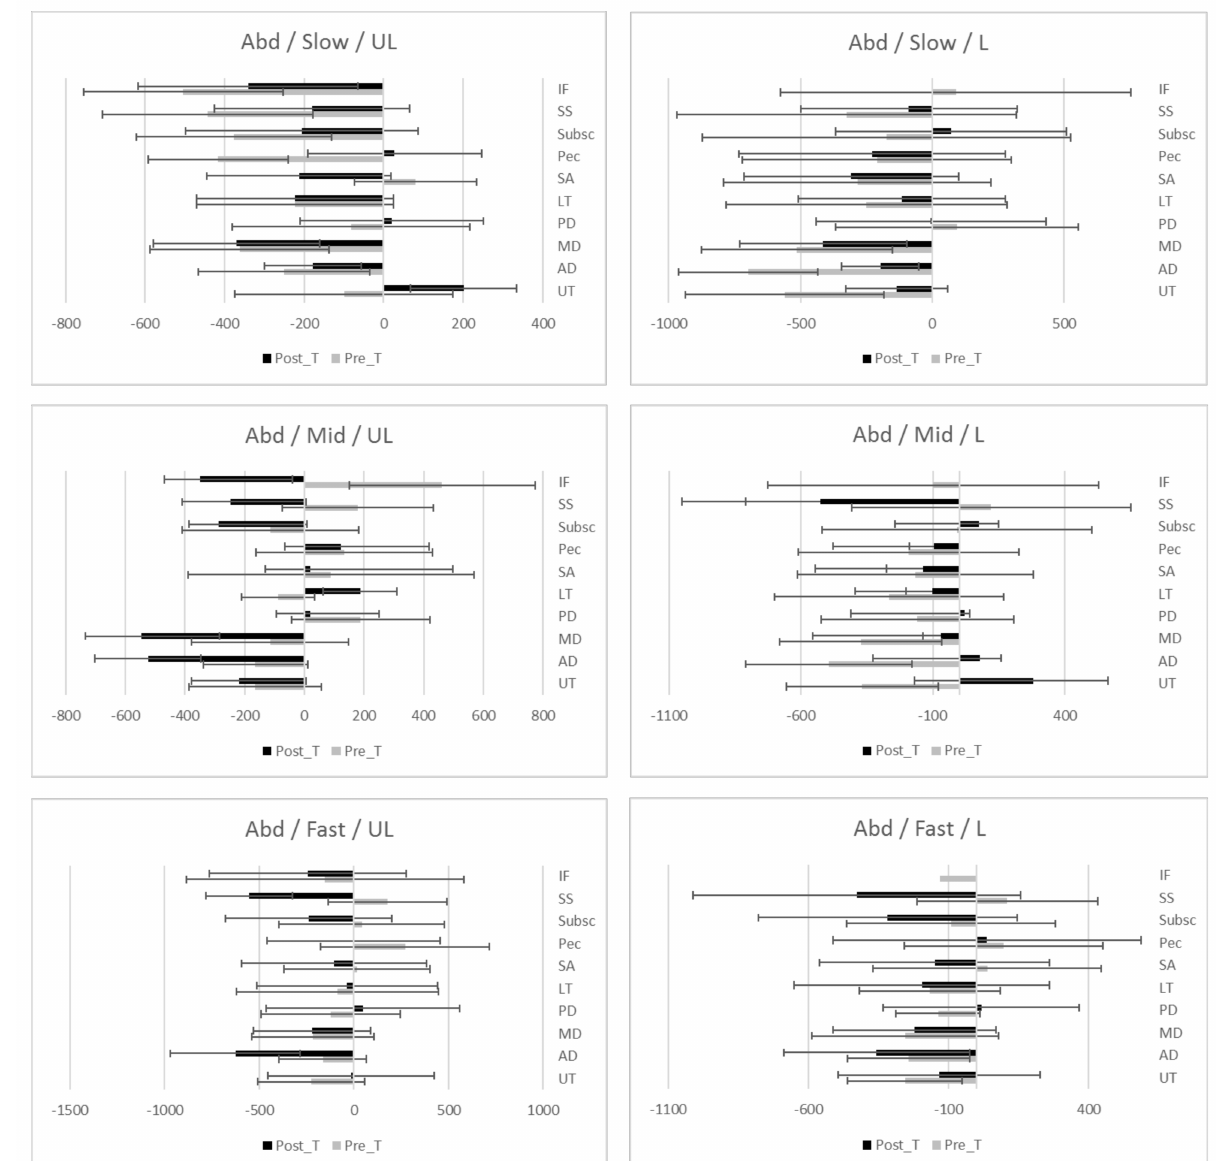
Figure 3. EMG onset time (ms) of activation (median ± IQR) during Abduction before and after standardized physiotherapy treatment for SIS. Descriptive data: Median, IQR (Inter Quartile Range) of onset time of activation during flexion movement at different load and speed. UL (Unloaded), L (Loaded), Slow (slow speed), Mid (medium speed) Fast (fast speed). Muscles; UT (Upper Trapezius), AD (Anterior Deltoid), MD (Mid Deltoid), PD (Posterior Deltoid), LT (Lower Trapezius), SA (Serratus Anterior), Pec (Pectoralis Major), Susbc (Subscapularis), SS (Supraspinatus), IF